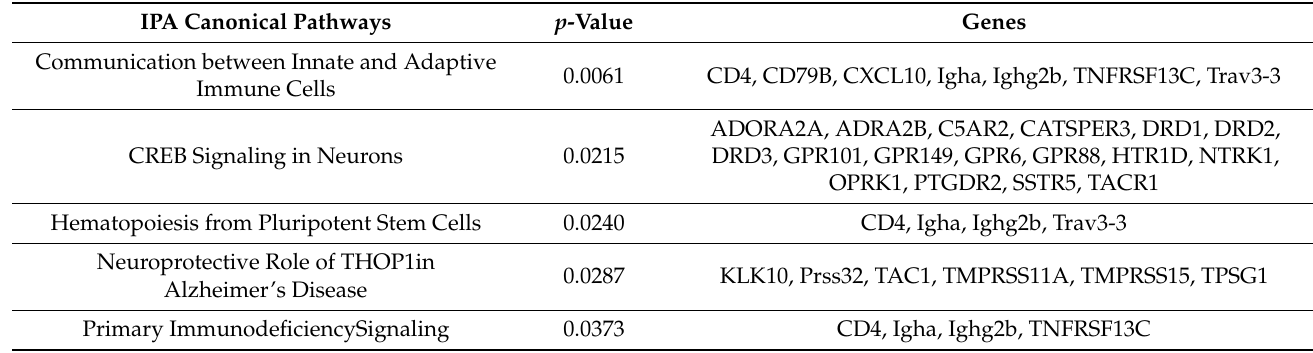
Table 1. Top five IPA enriched canonical pathways of the differentially deregulated genes in the frontal cortex of Tg2576 resilient mice versus Tg2576 impaired